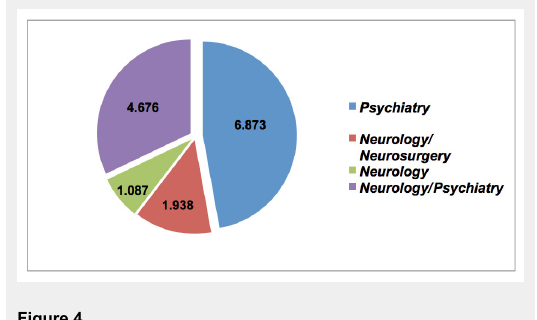
Total costs per discipline (million €PPP,